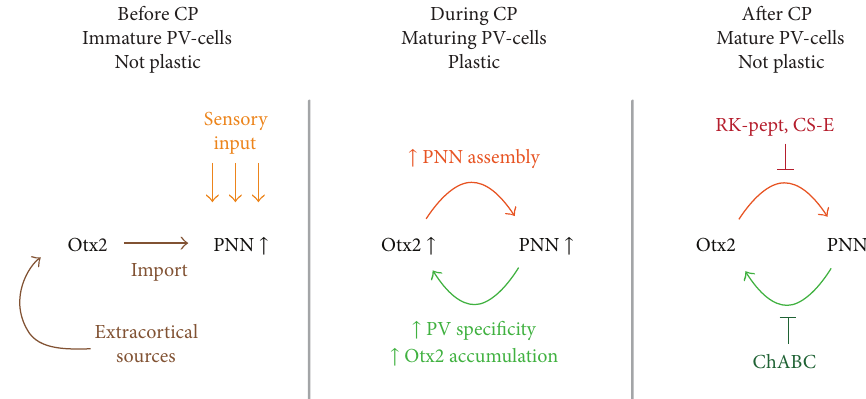
Figure 1: Otx2-PNN feedback loop for critical period plasticity . At critical period (CP) onset, sensory activity induces initial formation of the perineuronal nets (PNNs), allowing the internalization of extracortical Otx2 by PV-cells. During CP, the increasing PV-cell Otx2 content enhances PNN assembly. In turn, PNNs ensure the specific accumulation of Otx2 in the PV-cells. In the adult, the constant transfer of Otx2 into the PV-cells, due to the positive feedback loop between the homeoprotein and the PNNs, maintains a mature, consolidated, nonplastic state. Indeed, interfering with Otx2-PNN interaction in the adult (by injecting ChABC to remove PNNs or by infusing the GAG-binding domain of Otx2 (RK-peptide) or a CS-E analogue to block Otx2) reopens a window of plasticity in the visual cortex.